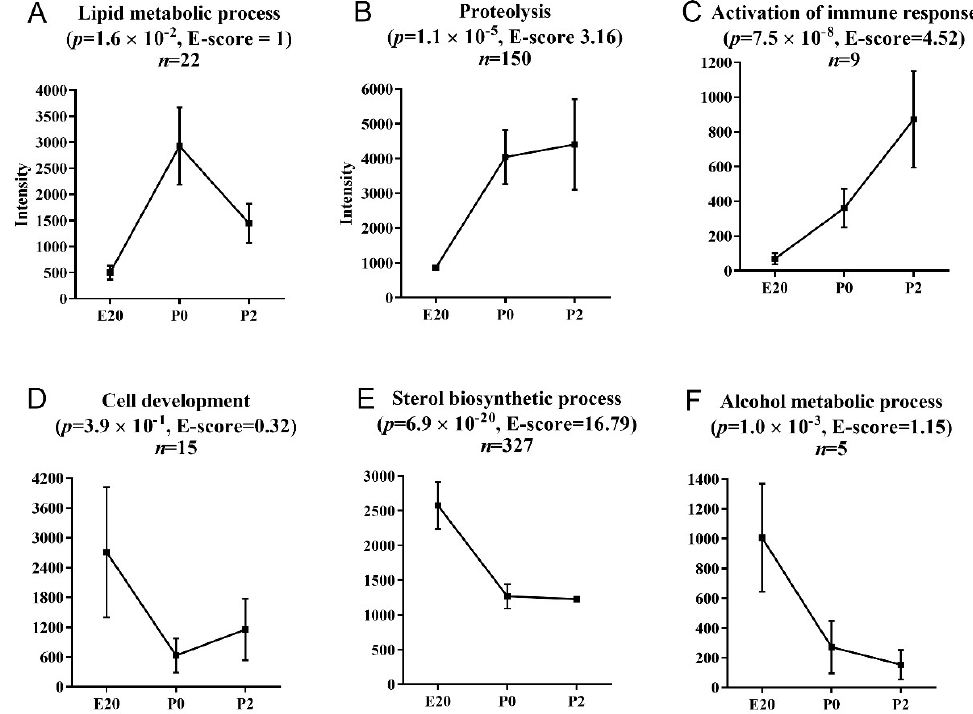
Figure 3. Functionally annotated gene clusters in normal perinatal rat pancreas samples. Differen- tially regulated transcripts in perinatal rat pancreas were clustered according to expression profiles over time and analyzed for enriched functional annotations using DAVID Functional Annotation Clustering. The most significantly enriched biological process in the highest scoring cluster is pre- sented above each graph. Data points represent mean intensities of the associated gene cluster at the given time point. ( A ) Lipid metabolic process, ( B ) proteolysis, ( C ) activation of the immune system, ( D ) cell development, ( E ) sterol biosynthetic process, ( F ) alcohol metabolic process. Error bars (SE) are included to illustrate the variability in expression levels. p -value: modified one-tailed Fisher’s exact probability value (EASE score); E-score: enrichment score, the geometric mean (in -log scale) of a member’s p -values (EASE scores) in the corresponding annotation cluster.